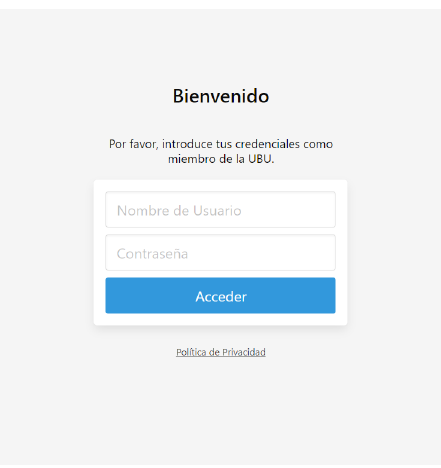
Figure 6. Login web form screenshot (Source: own authors’